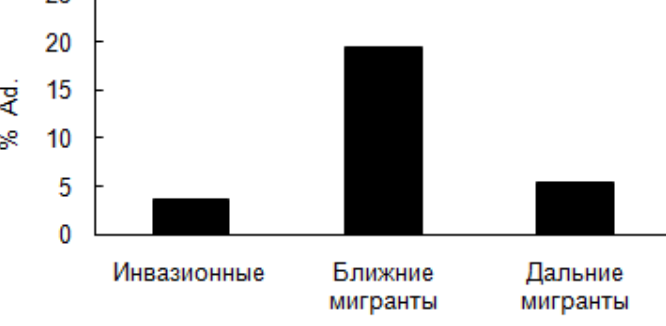
Рис. 3. Доля взрослых птиц в осенних отловах на Куршской